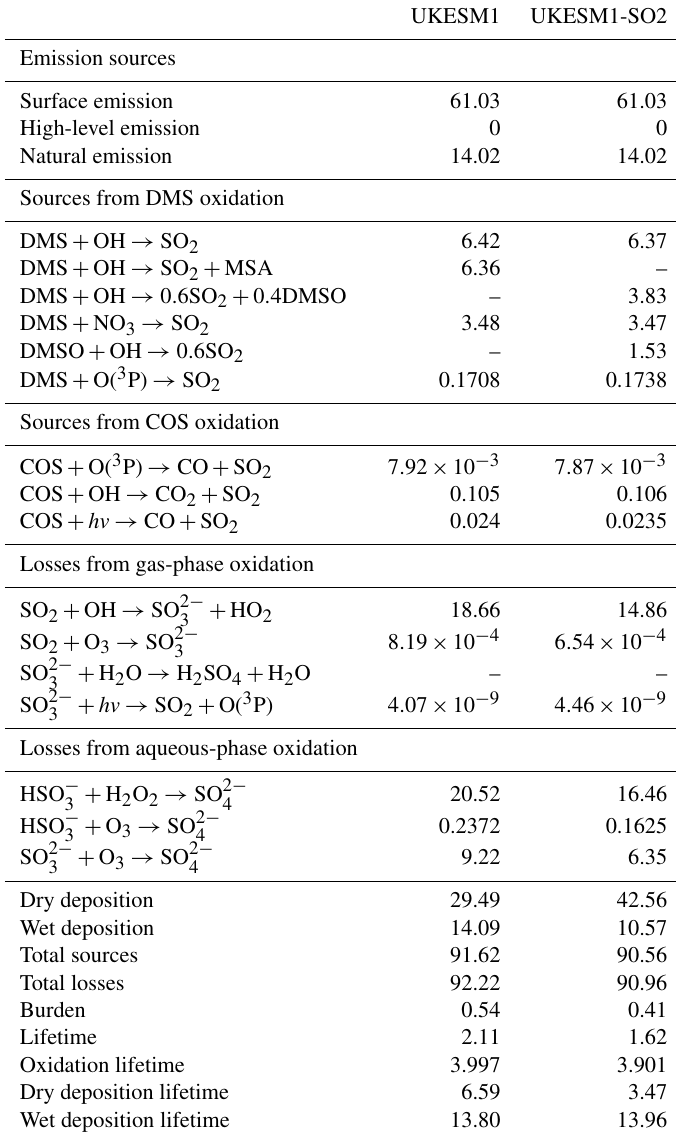
Table C1. Global SO 2 budget for UKESM1 and UKESM1-SO2. Units for production and loss fluxes are in Tg[S]yr − 1 , burdens are in Tg, and lifetimes are in days. The values are calculated from a 2-year AMIP simulation covering the period 1981–1983